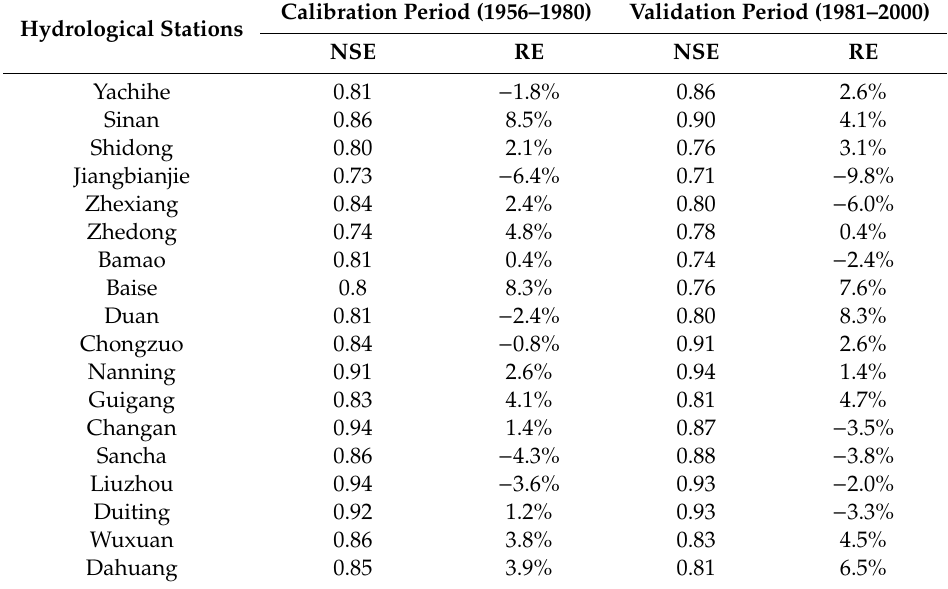
Table 4. Calibration and validation of simulated monthly discharge at 18 representative hydrological stations.